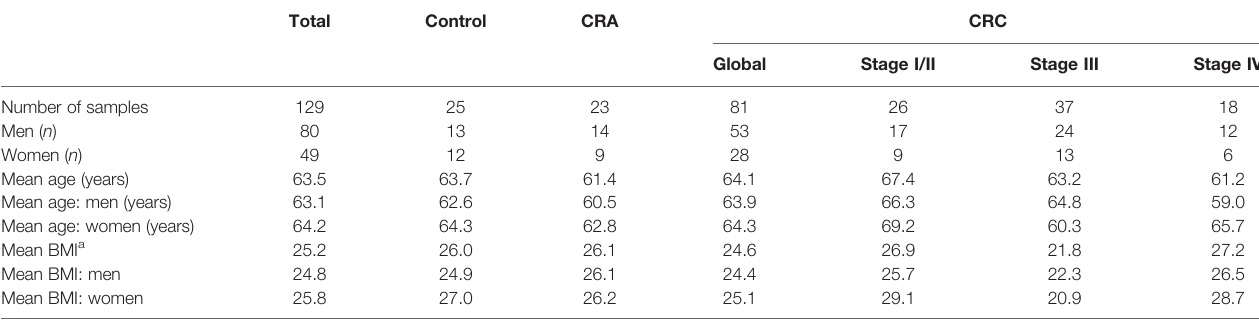
TABLE 1 | Characteristics of patients included in this